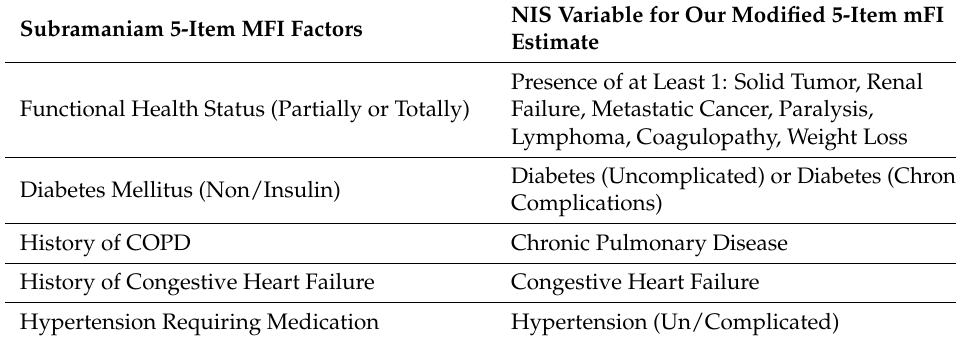
Figure 1. Abstract figure demonstrating main findings of risk factors for and protective factors mortality in paralytic ileus. against mortality in paralytic ileus. Table 7. Comparison of variables used for estimating 5-item modified frailty index